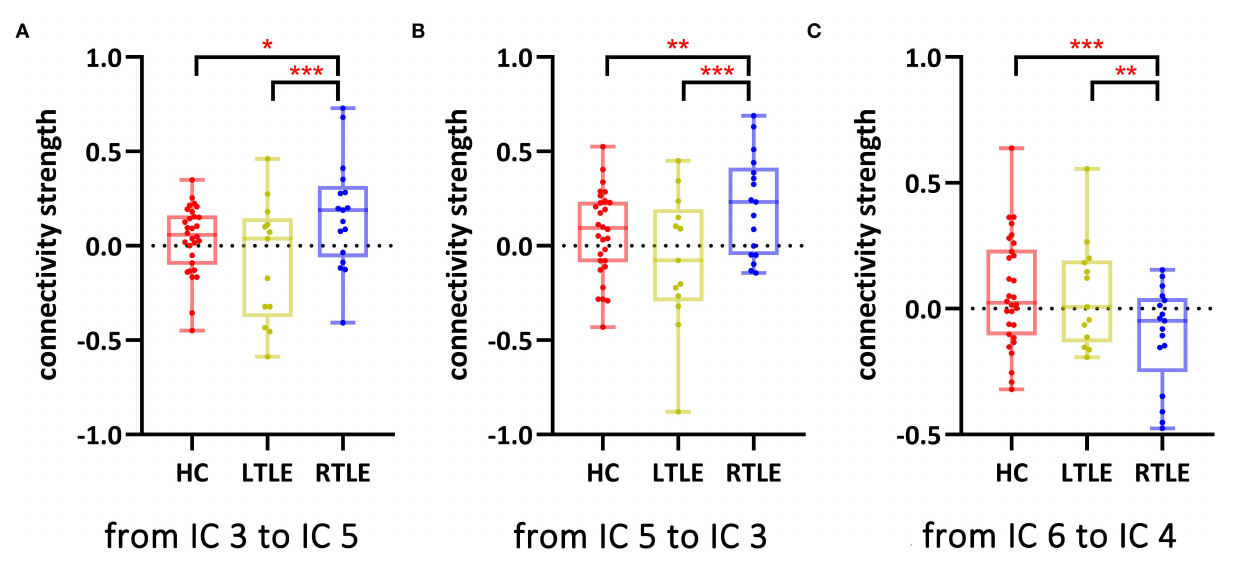
FIGURE2 Network functional connectivity with a significant group difference among the three groups. * p < 0.05, FDR-corrected; ** p < 0.005, FDR-corrected; *** p < 0.001, FDR-corrected. (A) Network functional connectivity from IC 3 to IC 5; (B) Network functional connectivity from IC 5 to IC 3; and (C) Network functional connectivity from IC 6 to IC 4. HC, healthy controls; IC, independent component; LTLE, left temporal lobe epilepsy; RTLE, right temporal lobe epilepsy.